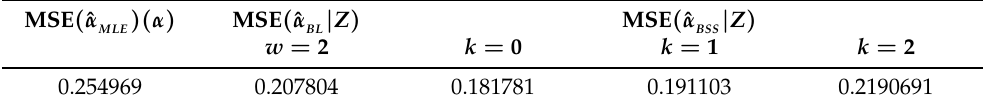
Table 11. Results of calculated MSE for ˆ α .